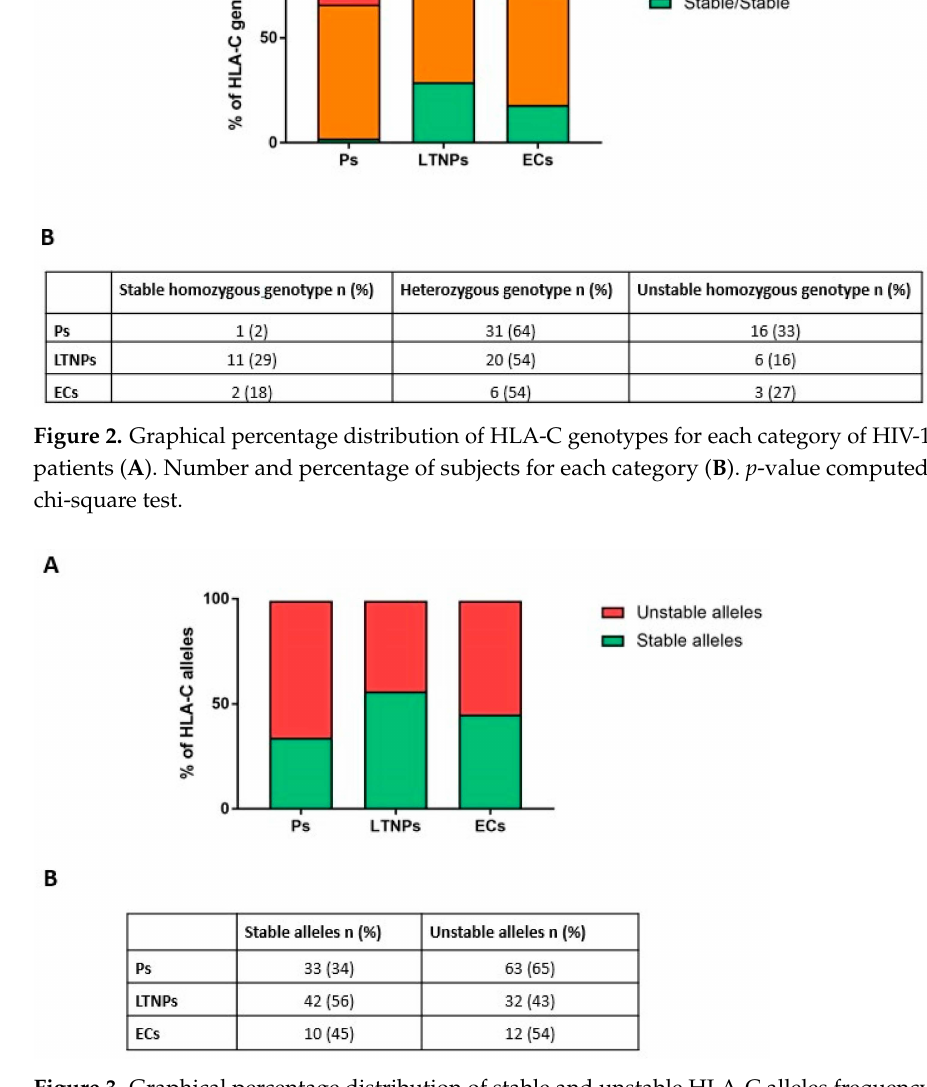
Figure 3. Graphical percentage distribution of stable and unstable HLA-C alleles frequency for each category of HIV-1-positive patients ( A ). Number and percentage of subjects for each category ( B ). p -value computed through chi-square